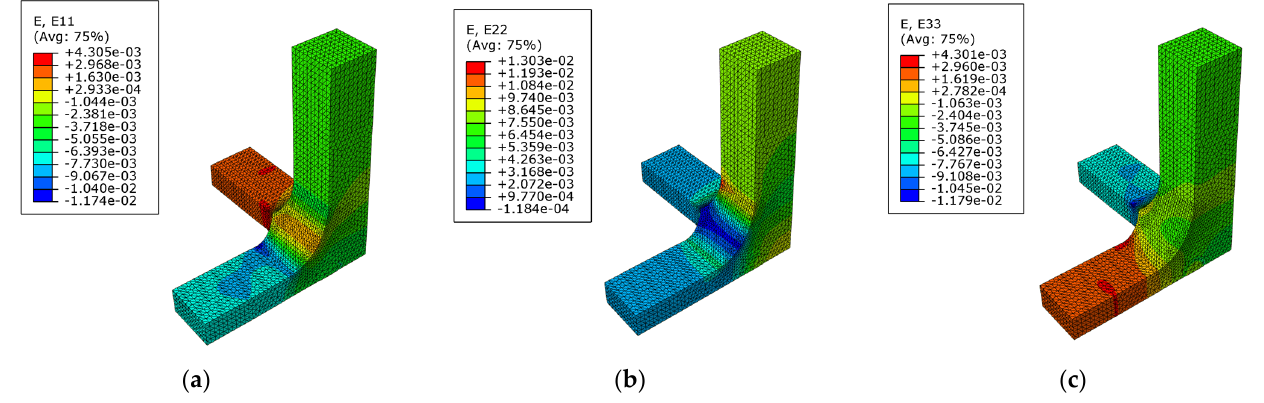
Figure 17. In geometry A for the CTC loading case and the scenario I: ( a ) Strain field in the x-direction; ( b ) strain field in the y-direction; ( c ) strain field in the z-direction.